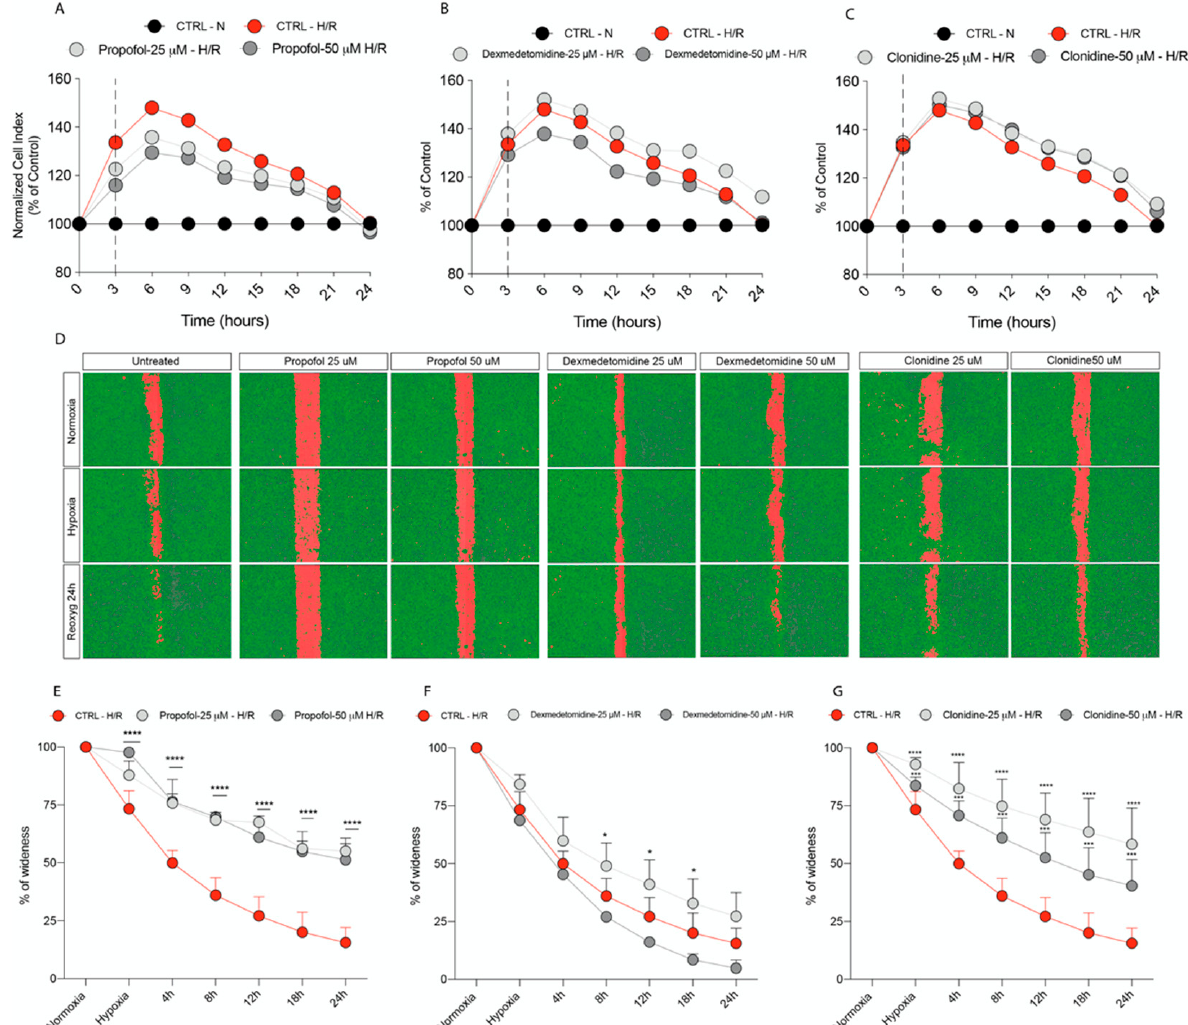
Figure 3. Real-time cell proliferation monitoring by xCELLigence system following treatments with ( A ) Propofol, ( B ) Demedetomidine, and ( C ) Clonidine, after Hypoxia (3 h) and Reoxygenation. Cell index values were normalized at the time of onset of hypoxia in order to obtain a normalized cell index. The value of normalized cell index of each treatment was normalized in % of normoxic control. Each line is expressing the average of four different experiments. ( D ) Cell migration analysis following treatments with ( E ) Propofol, ( F ) Dexmedetomidinel and ( G ) Clonidine, analyzed by Operetta High Content Screening. Values are presented as percentage of the open wound following Hypoxia (3 h) and 4, 8, 12, 18, and 24 h of Reoxygenation (wound at time 0 was assumed as 100% and used as control). Values are expressed as the mean ± SD of four different experiments. * vs. Untreated. (* p < 0.05; *** p < 0.001; **** p < 0.0001). Table 2. Normalized cell Index raw data values. Normalized Cell Index raw data values during Hypoxia and different time of reoxygenation following various pharmacological treatments. * p < 0.0001 vs. Untreated Normoxia, ** p < 0.005 vs. Untreated Hypoxia.